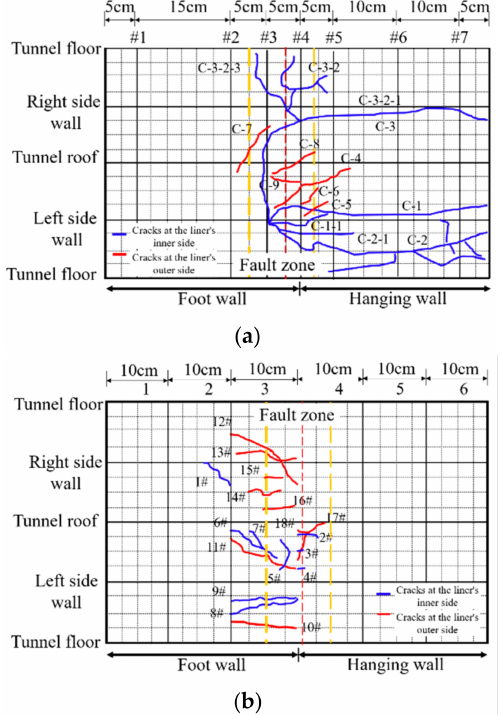
Figure 9. Distribution of cracks. ( a ) lining without joints; ( b ) lining with